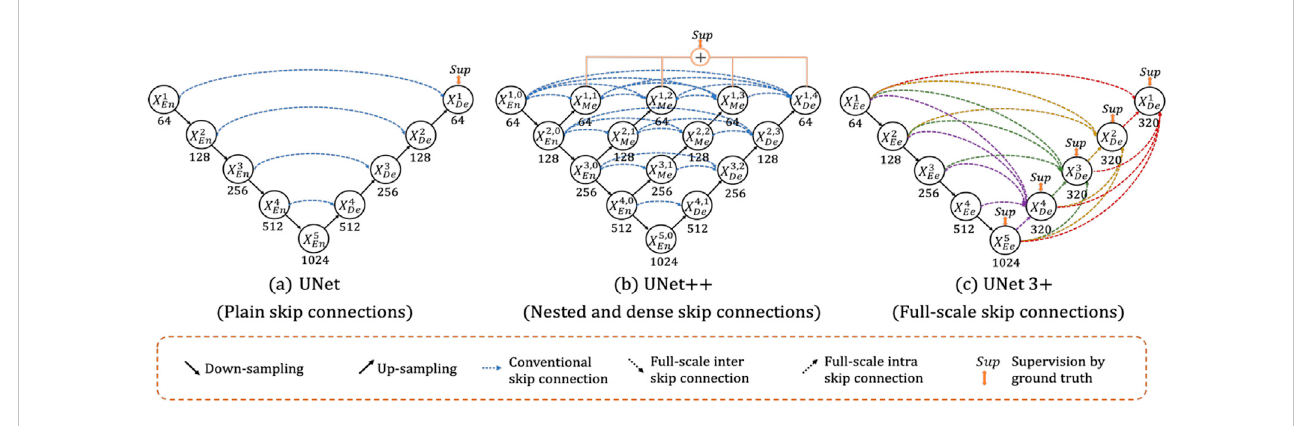
FIGURE 4 (A) U-Net, (B) UNet++, and (C) UNet 3 +